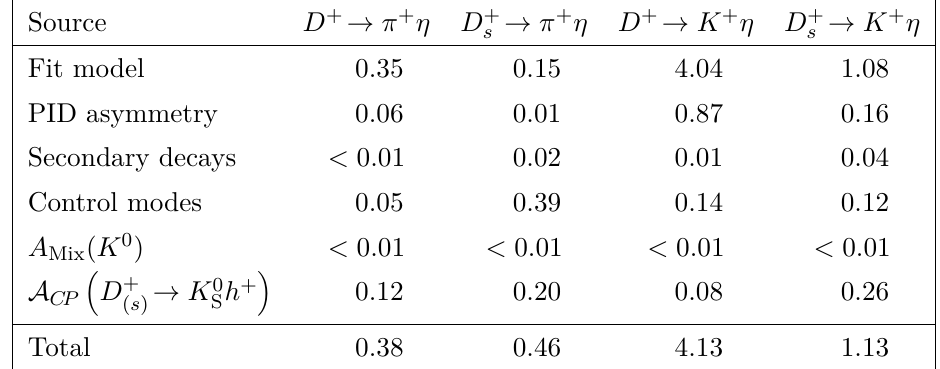
Table 4. Absolute systematic uncertainties (%) on the CP asymmetries for D +